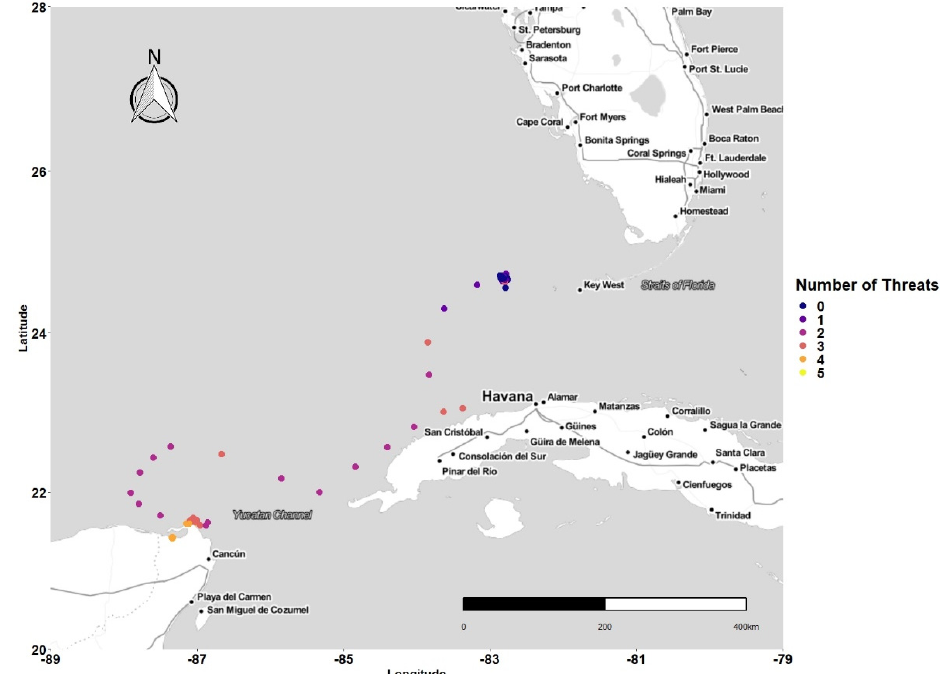
Figure A3. State-space model (SSM) points of Turtle #8, a green turtle ( Chelonia mydas ) that migrated from Dry Tortugas National Park to the Yucatan Peninsula between 7 June 2018 and 19 January 2019. Each color represents the number of unique high threat categories encountered on that given day within a 2 km buffer of the SSM point. Note that tracking data stops before this turtle returned.